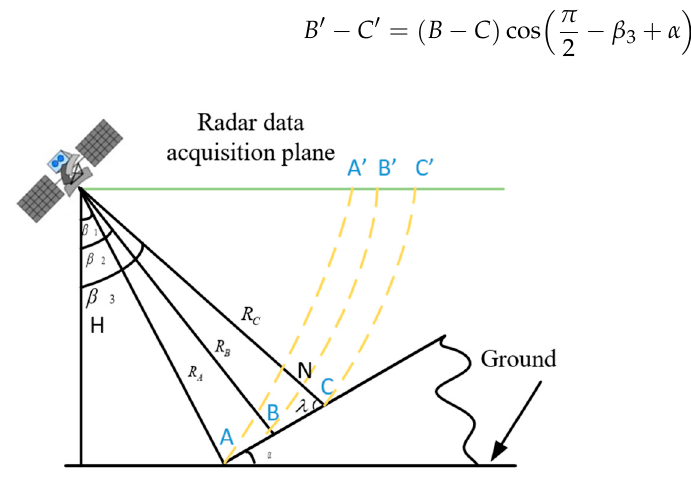
Figure 3. SAR imaging model.